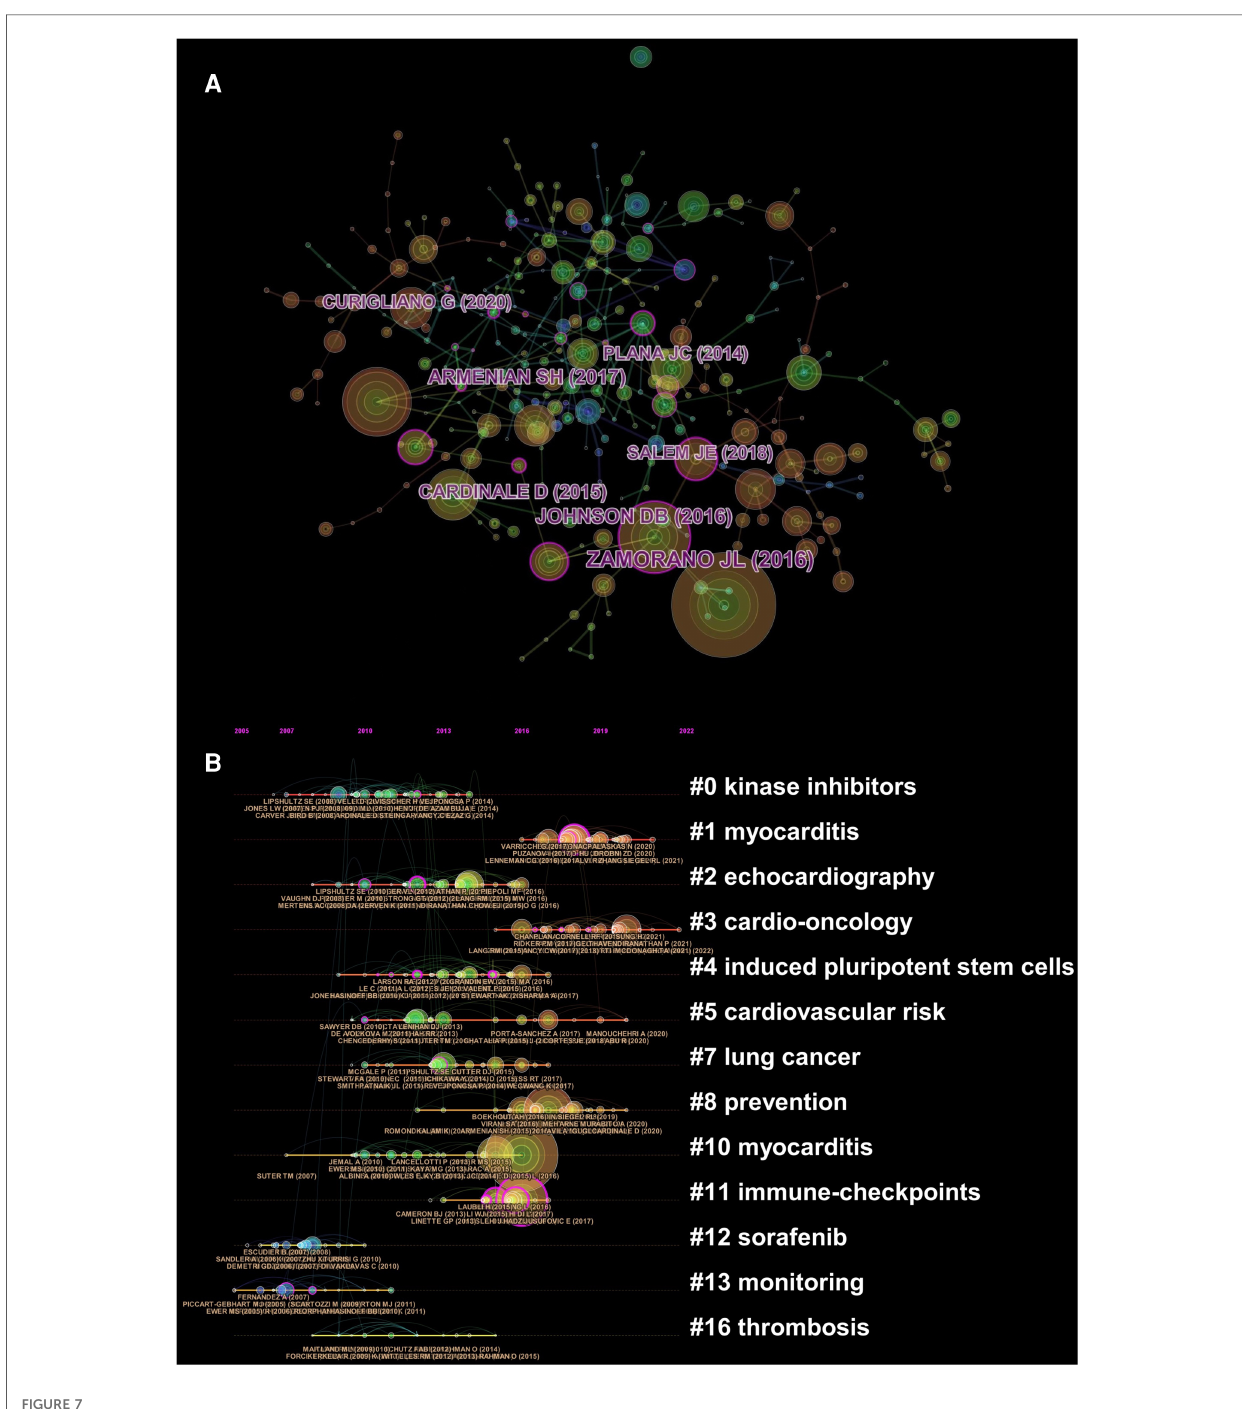
FIGURE 7 ( A) the citation map of reference in cardiotoxicity. ( B ) Timeline view of co-cited references of cardiotoxicity by using CiteSpace software. Thirteen cluster tags representing hot themes were selected and ranked on the right of Figure based on the loglikelihood ratio (LLR) algorithm. Along the dashed line linked to each tag, circles with larger radius represented higher citation frequencies and warmer colored lines represented later publication